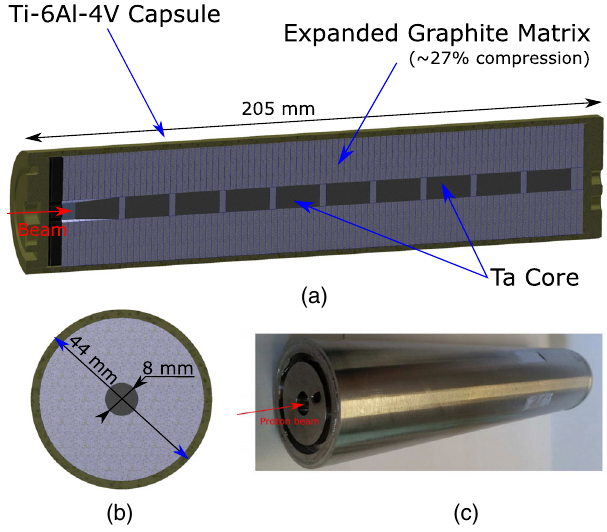
FIG. 1. (a) Half-cut of the HRMT-42 target geometry. (b) Cross-section of the HRMT-42 target geometry. (c) Picture of the